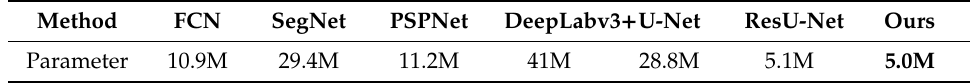
Table 3. The parameters of various models (the model with the fewest parameters is indicated in